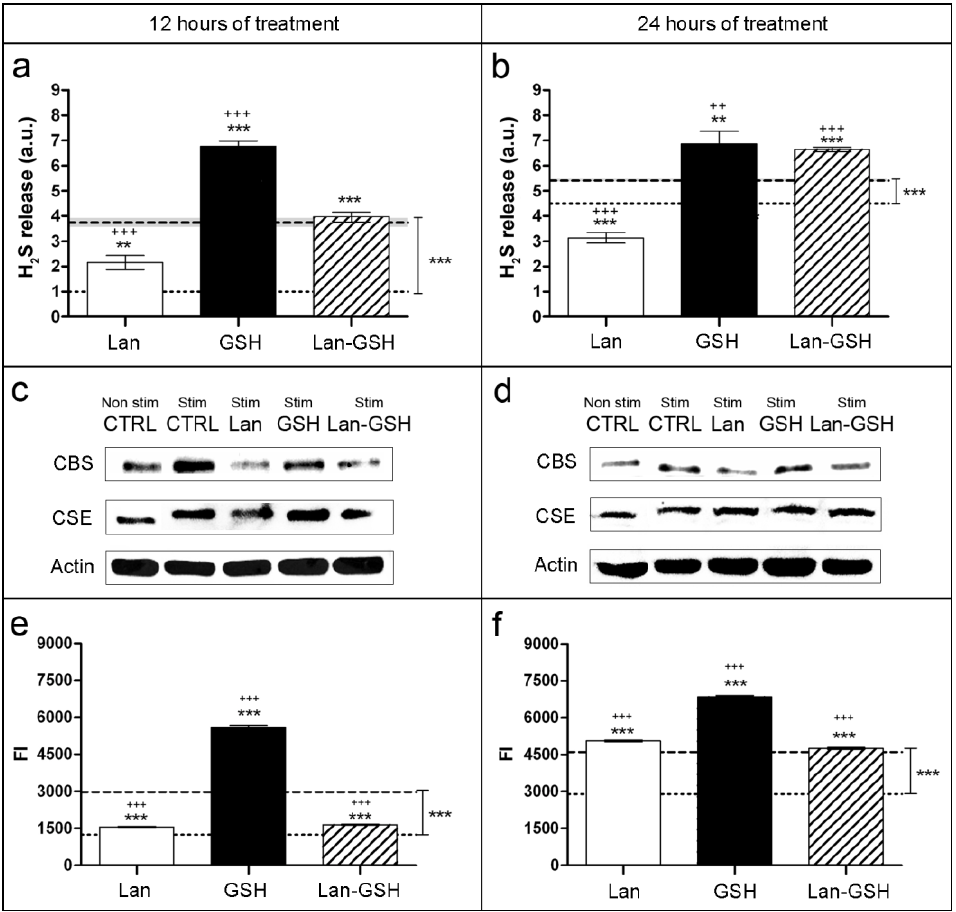
Figure 1. E ff ects of lanthionine on H 2 S release, sulfane sulfur levels, CBS and CSE protein levels. Cells were incubated with 0.3 µ M lanthionine and / or 1 mM GSH, under “stimulated” conditions. H 2 S release in 12 h ( a ) and in 24 h ( b ) is expressed in arbitrary units (a.u.) normalized to the untreated (non-stimulated) control at 12 h, which is made equal to 1. Western blot analysis of CBS and CSE proteins abundance in samples treated during 12 h ( c ) and 24 h ( d ) is shown; β -actin is the loading control. Relative quantity of sulfane sulfur species in endothelial cells, treated for 12 h ( e ) and in 24 h ( f ), were detected using fluorescent probe SSP4 and expressed as fluorescence intensity (FI). In a,b,e,f, dotted lines indicate the average values of untreated controls and bold dashed lines indicate the average values of stimulated control. In all experiments Lan, GSH, Lan with GSH and stimulated controls were incubated with 1 mM Cys, 1 mM vitamin B 6 and 5 µ M SAM, 2 h before treatment started. In a and b the columns represent the mean and error bars indicating the SD from three independent experiments. Gray area behind bold dashed lines represent the SD for stimulated controls; p value versus untreated control = ** p < 0.01, *** p < 0.001, while p value versus stimulated control = ++ p < 0.01, +++ p < 0.001 (according to Student’s t -test). In e and f, the columns represent the mean and error bars indicate the percent coe ffi cient of variation (%CV) of 10 4 events; p value versus untreated control = *** p < 0.001, while p value versus stimulated control = +++ p < 0.001 (according to Student’s t -test). CTRL, control; Lan, lanthionine; GSH, glutathione; CBS, cystathionine- β -synthase; CSE, cystathionine- γ -lyase; Cys, cysteine; SAM, S